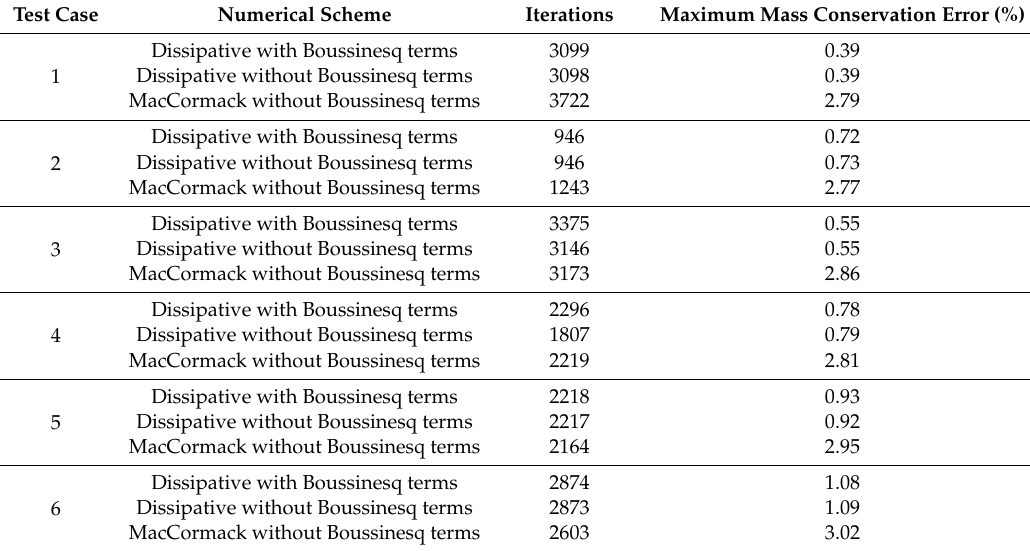
Table 2. Required iterations for convergence and mass balance